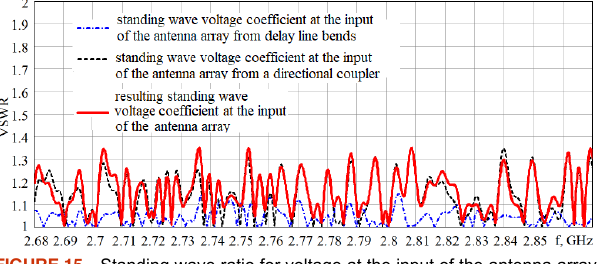
FIGURE 14. Structural diagram of an antenna array with an optimized geometry of the power divider.